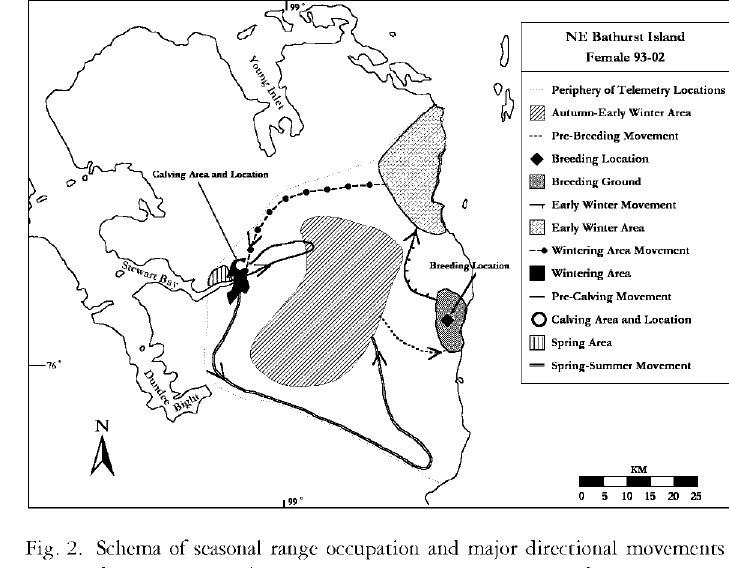
Fig. 2. Schema of seasonal range occupation and major directional movements of female Peary caribou 93-02 during the annual-cycle of the study period, Bathurst Island, Canadian High Arctic, 1 August 1993 to 31 July 1994: extrapolated from satellite location-data